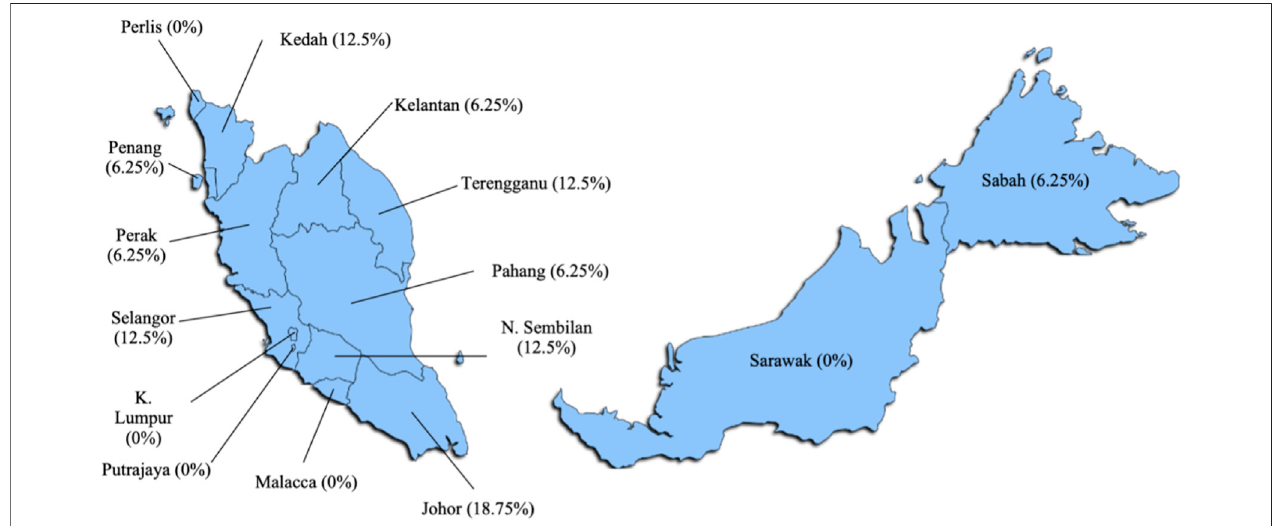
FIGURE 1 | Total number of schools participated in the Energy Ef fi ciency Challenge from 2016 to